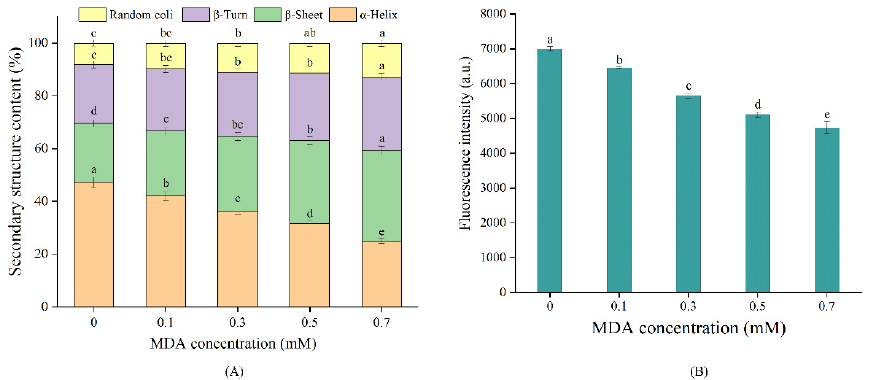
Figure 2. Effect of MDA on MP secondary structures ( A ), surface hydrophobicity ( B ). Different let- ters (a, b, c, d, e) indicate a significant difference ( p < 0.05, n =